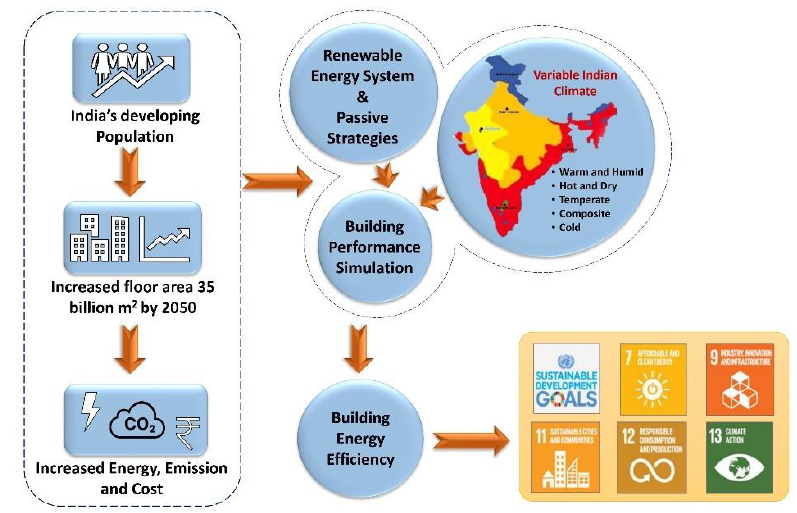
Figure 2. Need for building energy efficiency in India to attain SDG.